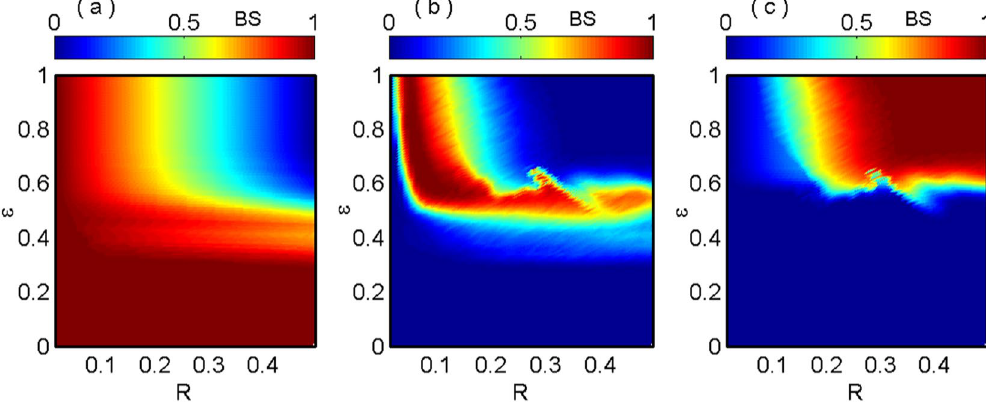
Figure 6. Coexistence of different dynamical states are quantified by a color bar of basin stability measure in  − R parameter space of nonlocally coupled MG oscillators: ( a ) incoherent, ( b ) chimera and ( c ) coherent